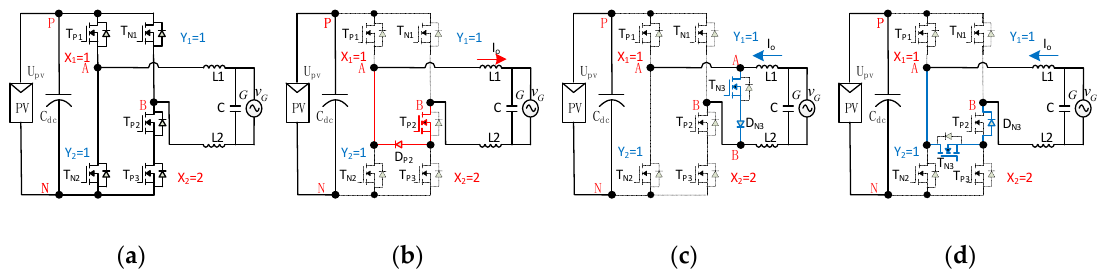
Figure 10. Four modes under X 1 = 1, X 2 = 2, Y 1 = 1, and Y 2 = 1. ( a ) PC and NC modes; ( b ) PF mode; ( c ) NF mode #1; ( d ) NF mode #2.